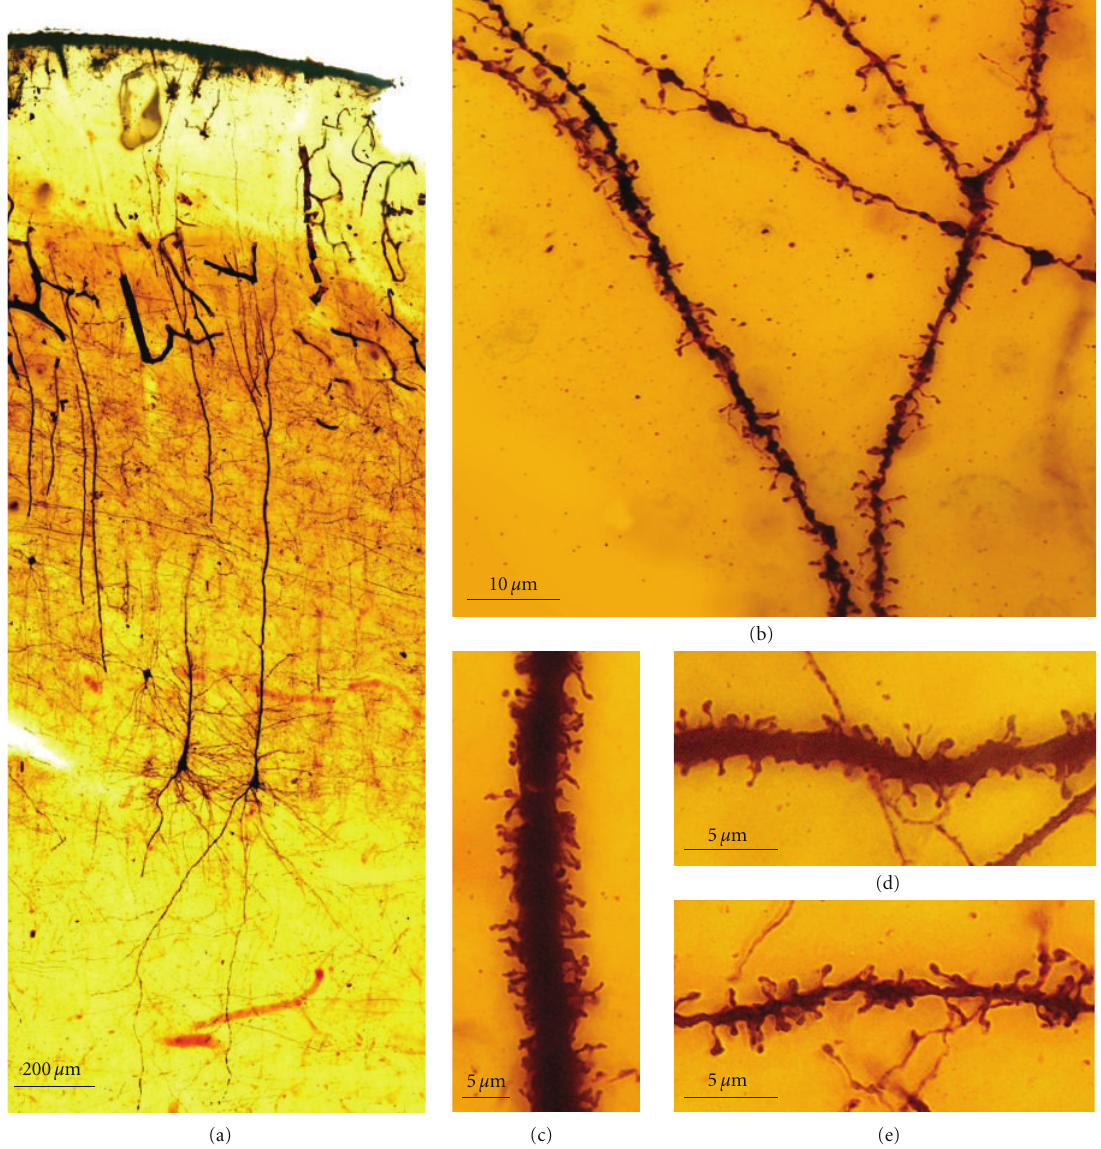
Figure 15: The figure represents protospines, dendritic spines, and some filopodia. (a) Layer V pyramidal cells, motor cerebral cortex, 15-day-old child, Cajal histological preparation, Golgi-method. (b) Apical tuft. (c) Apical trunk. (d) Oblique apical dendrite. (e) Basilar